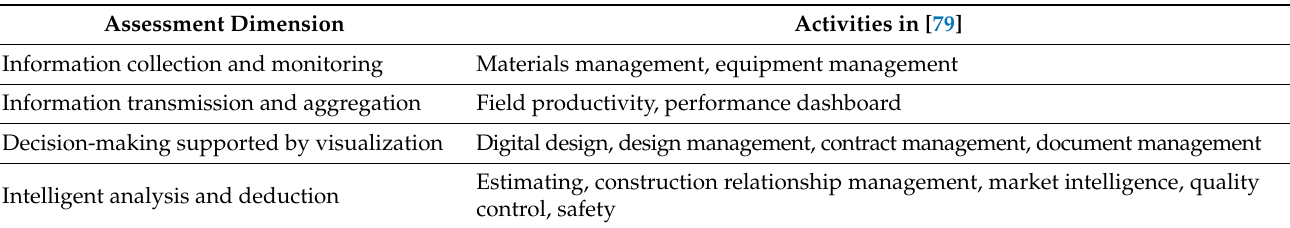
Table 3. Assessment dimensions and their components for IT and managerial approaches.